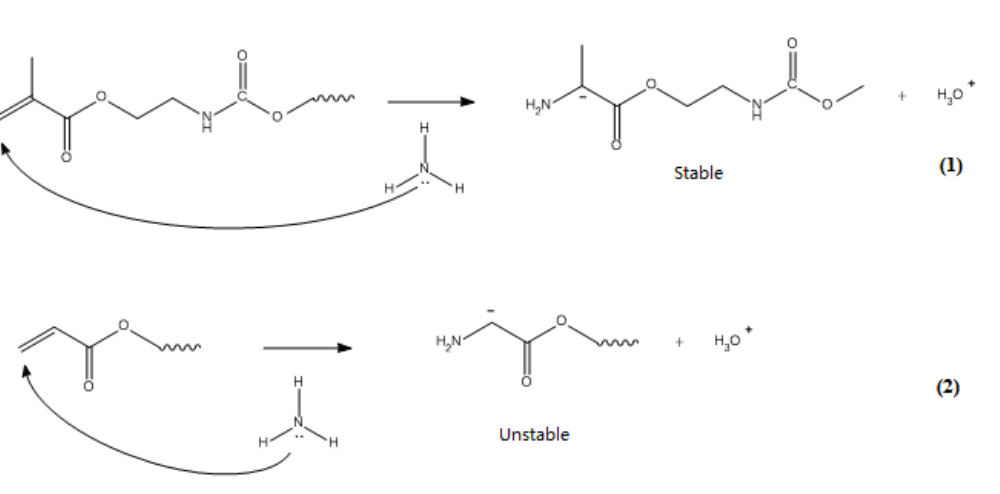
Figure 3. Mechanism of the Michael addition reaction of PEGOMA and PEGOA with ammonia water.